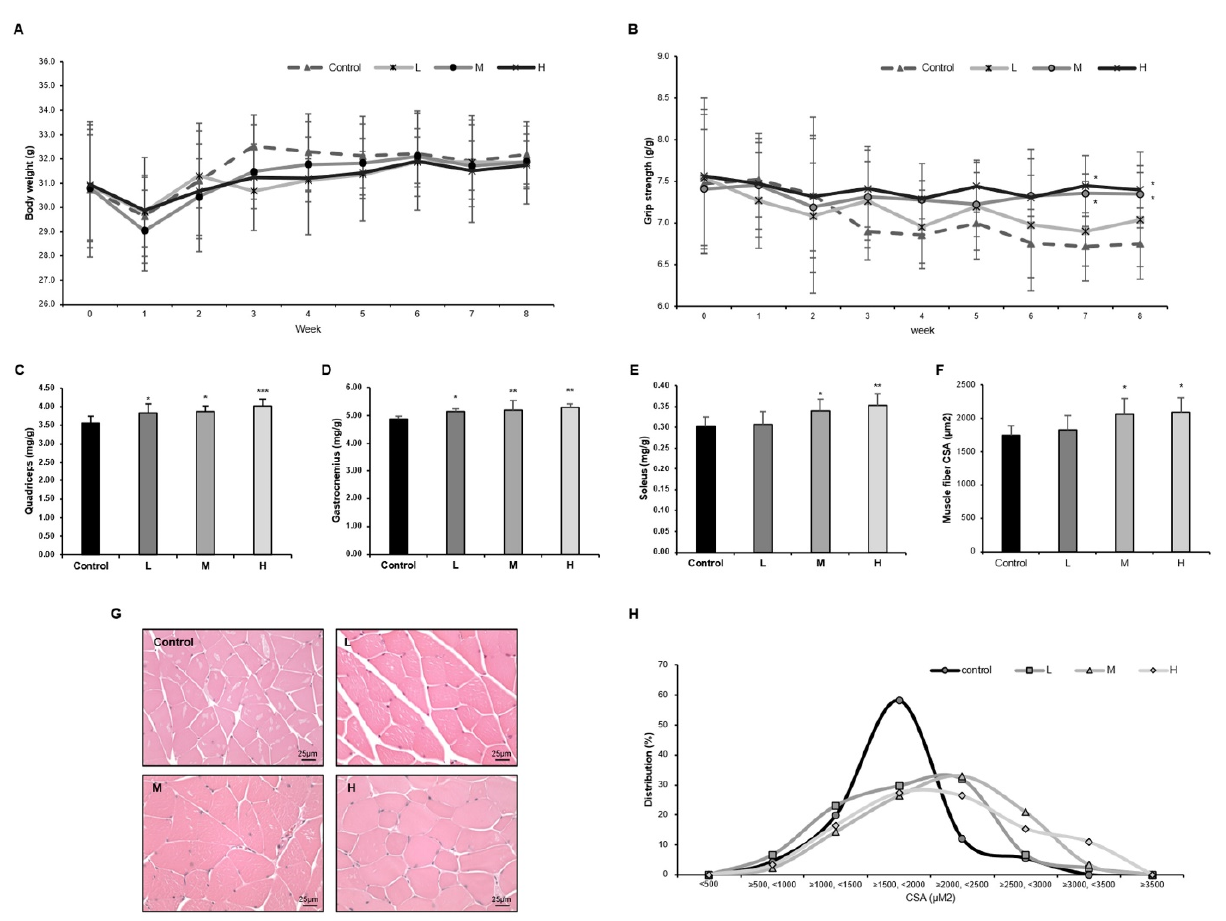
Figure 2. Effect of the GBE + WPH mixture on muscle atrophy in aged mice. Ten-month-old male C57BL/6 mice were administered three different doses of the GBE + WPH mixture for 8 weeks; 700 mg/kg, 900 mg/kg, and 1100 mg/kg. ( A ) Body weight curves. ( B ) Grip strength curves. ( C ) The weight of quadriceps muscle tissue. ( D ) The weight of gastrocnemius muscle tissue. ( E ) The weight of soleus muscle tissue. ( F ) The mean cross-sectional area (CSA) of each muscle fiber. ( G ) H&E staining of gastrocnemius. ( H ) The distribution graph of muscle fiber CSA. Scale bars 25 µm. The data are shown as mean ± SD. * p < 0.05, ** p < 0.01, *** p < 0.001 versus control.